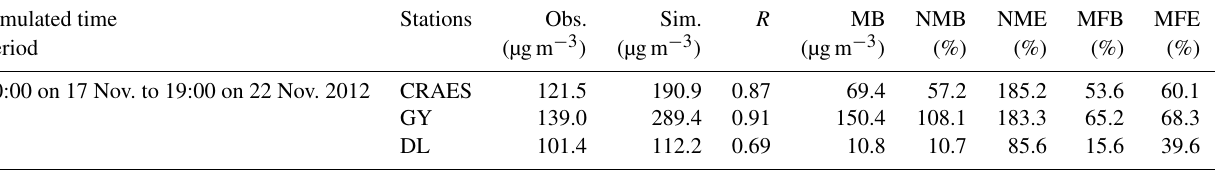
Figure 8. (a–c) Comparisons of the observed (black solid triangles) and simulated (blue dotted line) hourly PM 2 . 5 concentrations at the CRAES, GY, and DL stations; (d) hourly variations in the average PM 2 . 5 concentrations over Beijing. Please note that the date and time are given in DD HH:MM format, with all dates in November 2012. Table 2. Performance statistics of PM 2 . 5 concentrations. Simulated time Stations